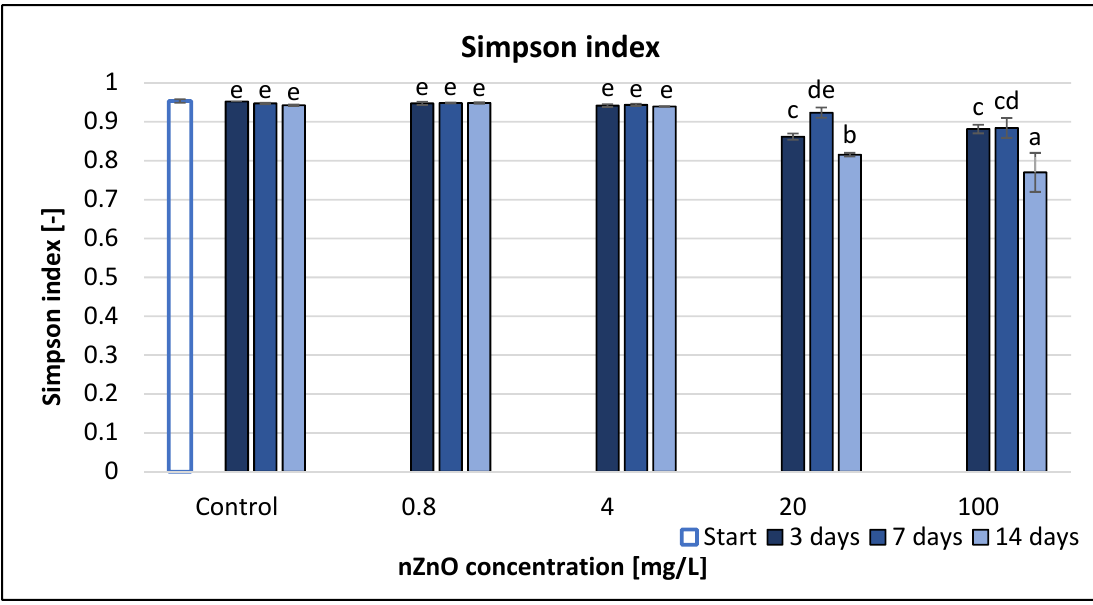
Figure 6. The effect of ZnO nanoparticles on freshwater Simpson index value. Letters on the columns indicate significant differences (level of significance: p < 0.05).